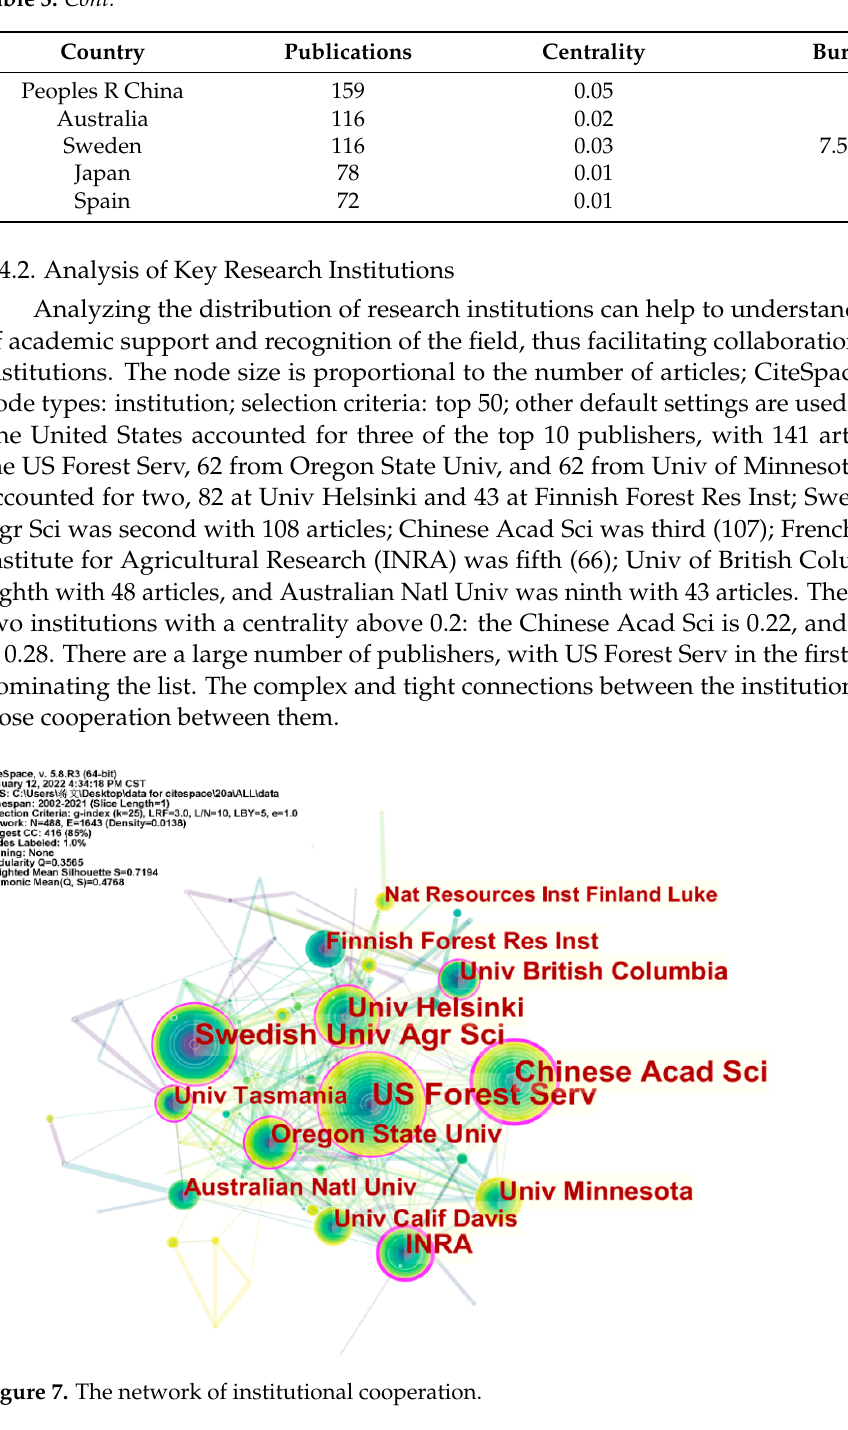
Table 3. Top 10 countries on the number of published papers.